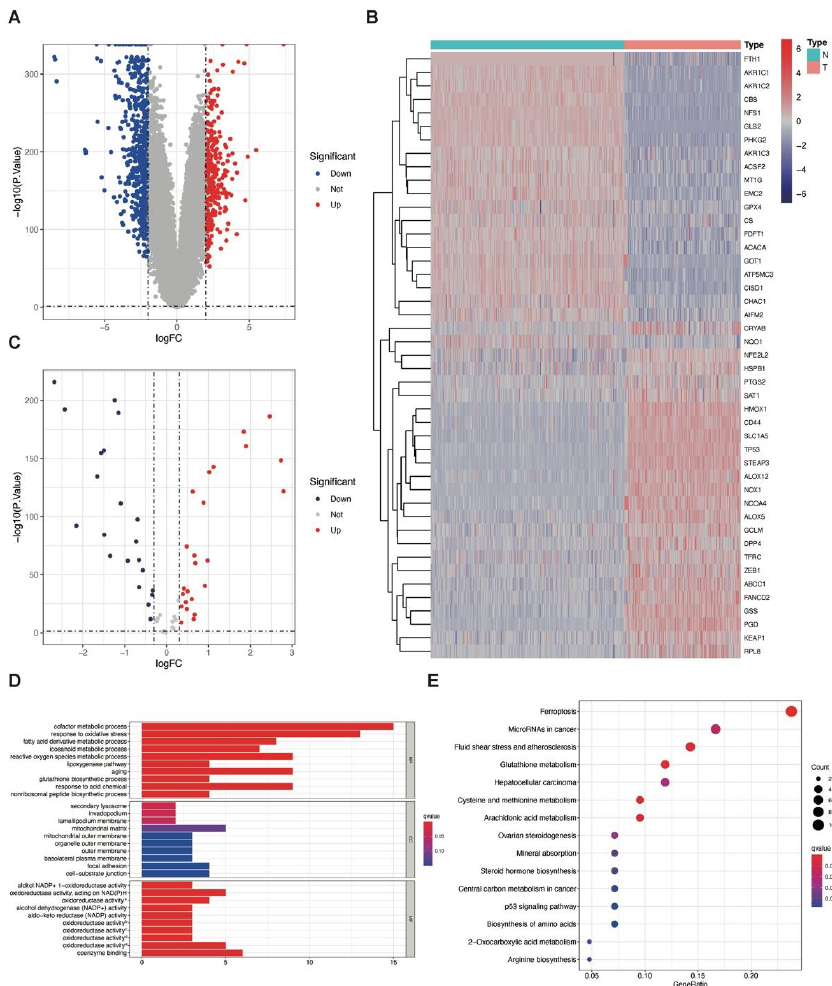
Figure 1. An overview of comprehensive and ferroptosis-related differentially expressed genes. ( A ) Volcano plot of all differentially expressed genes (DEGs) between GBM and normal brain tissue. ( B ) A heatmap of 45 ferroptosis-related genes showed the different expression patterns between GBM and normal brain tissue. ( C ) Volcano plot of 45 ferroptosis-related DEGs between GBM and normal brain tissue; 24 DEGs were upregulated and 21 DEGs were downregulated. ( D ) Gene set enrichment analysis of gene ontology (GO) among the ferroptosis-related DEGs. BP: biological process; CC: cellular component; MF: molecular function. ( E ) Gene set enrichment analysis of Kyoto Encyclopedia of Genes and Genomes (KEGG) among the ferroptosis-related DEGs. Gene ratio: the proportion of the enriched genes to the total amount of genes in a specific pathway.